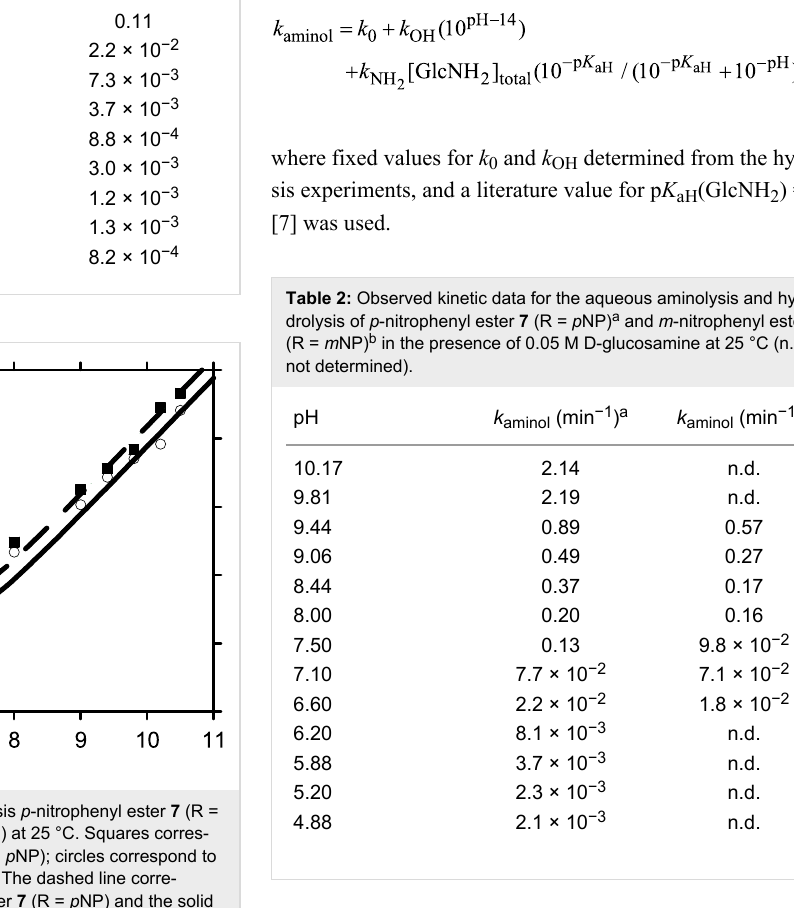
The pseudo first order rate coefficients, k 0 , for water-promoted hydrolyses of p -nitrophenyl ester 7 (R = p NP) and m -nitro- phenyl ester 7 (R = m NP) were 1.8 × 10 − 3 min − 1 and 1.1 × 10 − 3